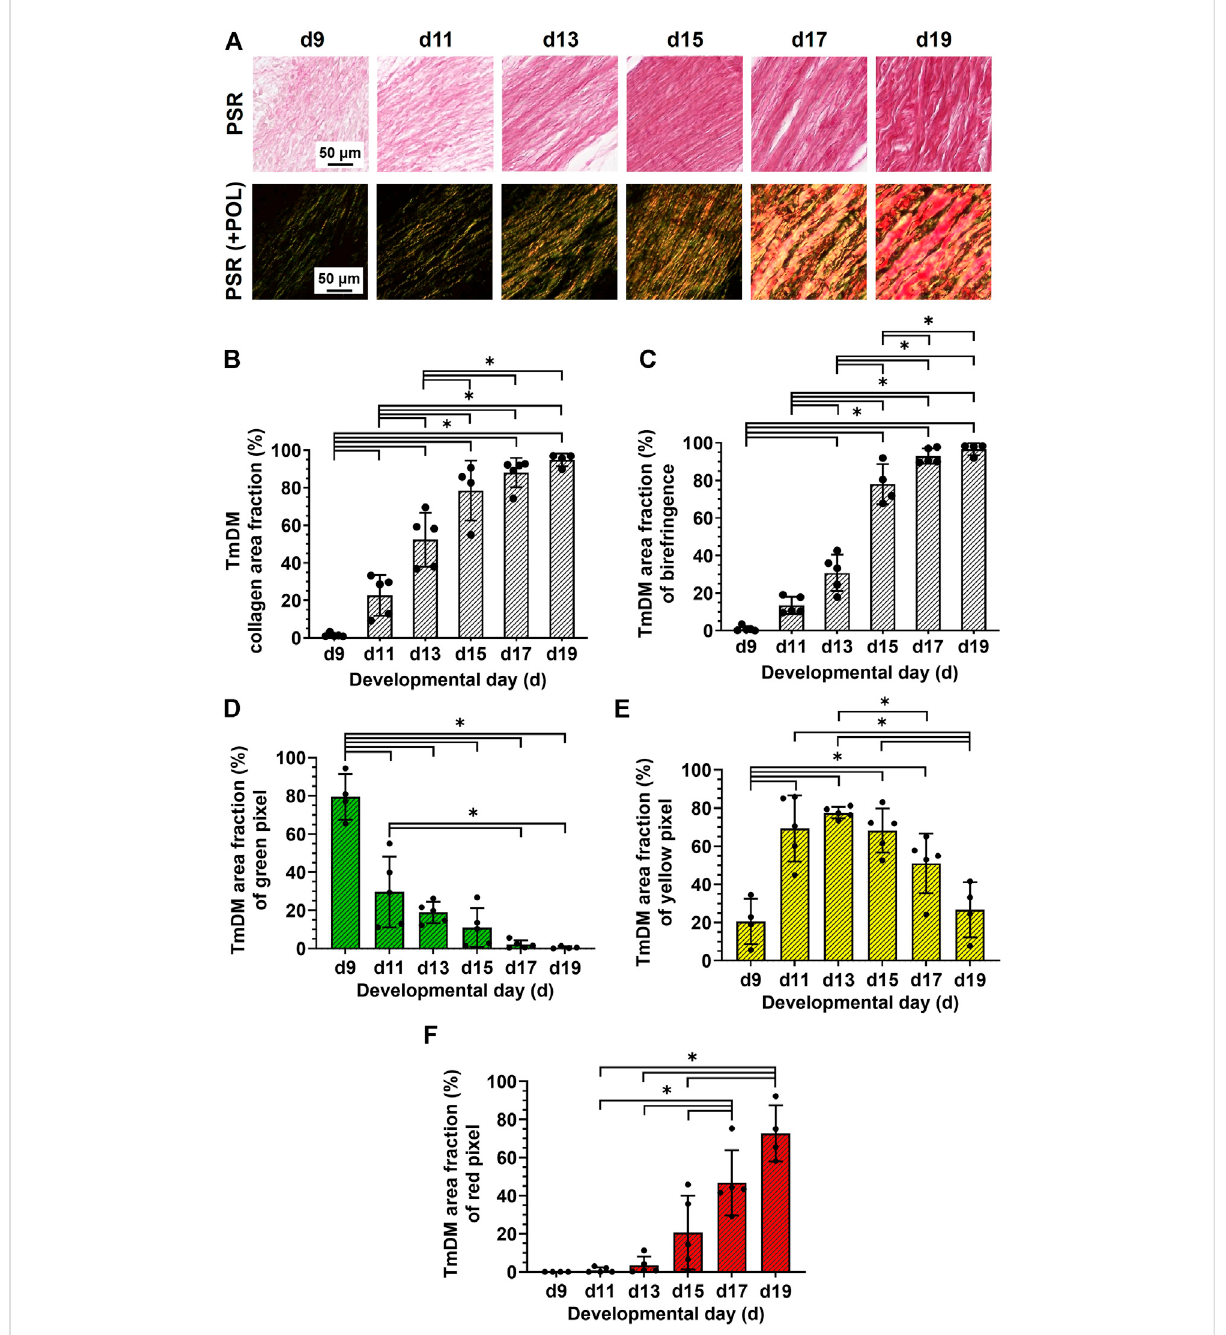
FIGURE 5 Collagen content increased, collagen became more aligned, and fi ber maturity increased in jaw-opening TmDM between d9 and d19. (A) Representative bright fi eld and polarization images of PSR-stained TmDM. (B) Collagen content increased signi fi cantly over time and plateaued after d15 in TmDM. (C) In the TmDM, collagen birefringence increased signi fi cantly over time and reached a plateau after d17. (D – F) Collagen fi bers in TmDMprogressedfrommainlyimmature (D) duringearlystages,tointermediate (E) ,and fi nallytomature (F) duringlatestagesofdevelopment.